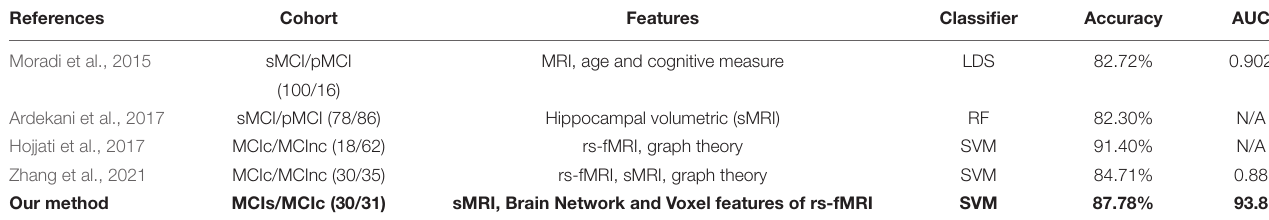
Bold value represents the results obtained form proposed method. TABLE 7 | Performance comparison of MCIs vs. MCIc with state-of-the-art